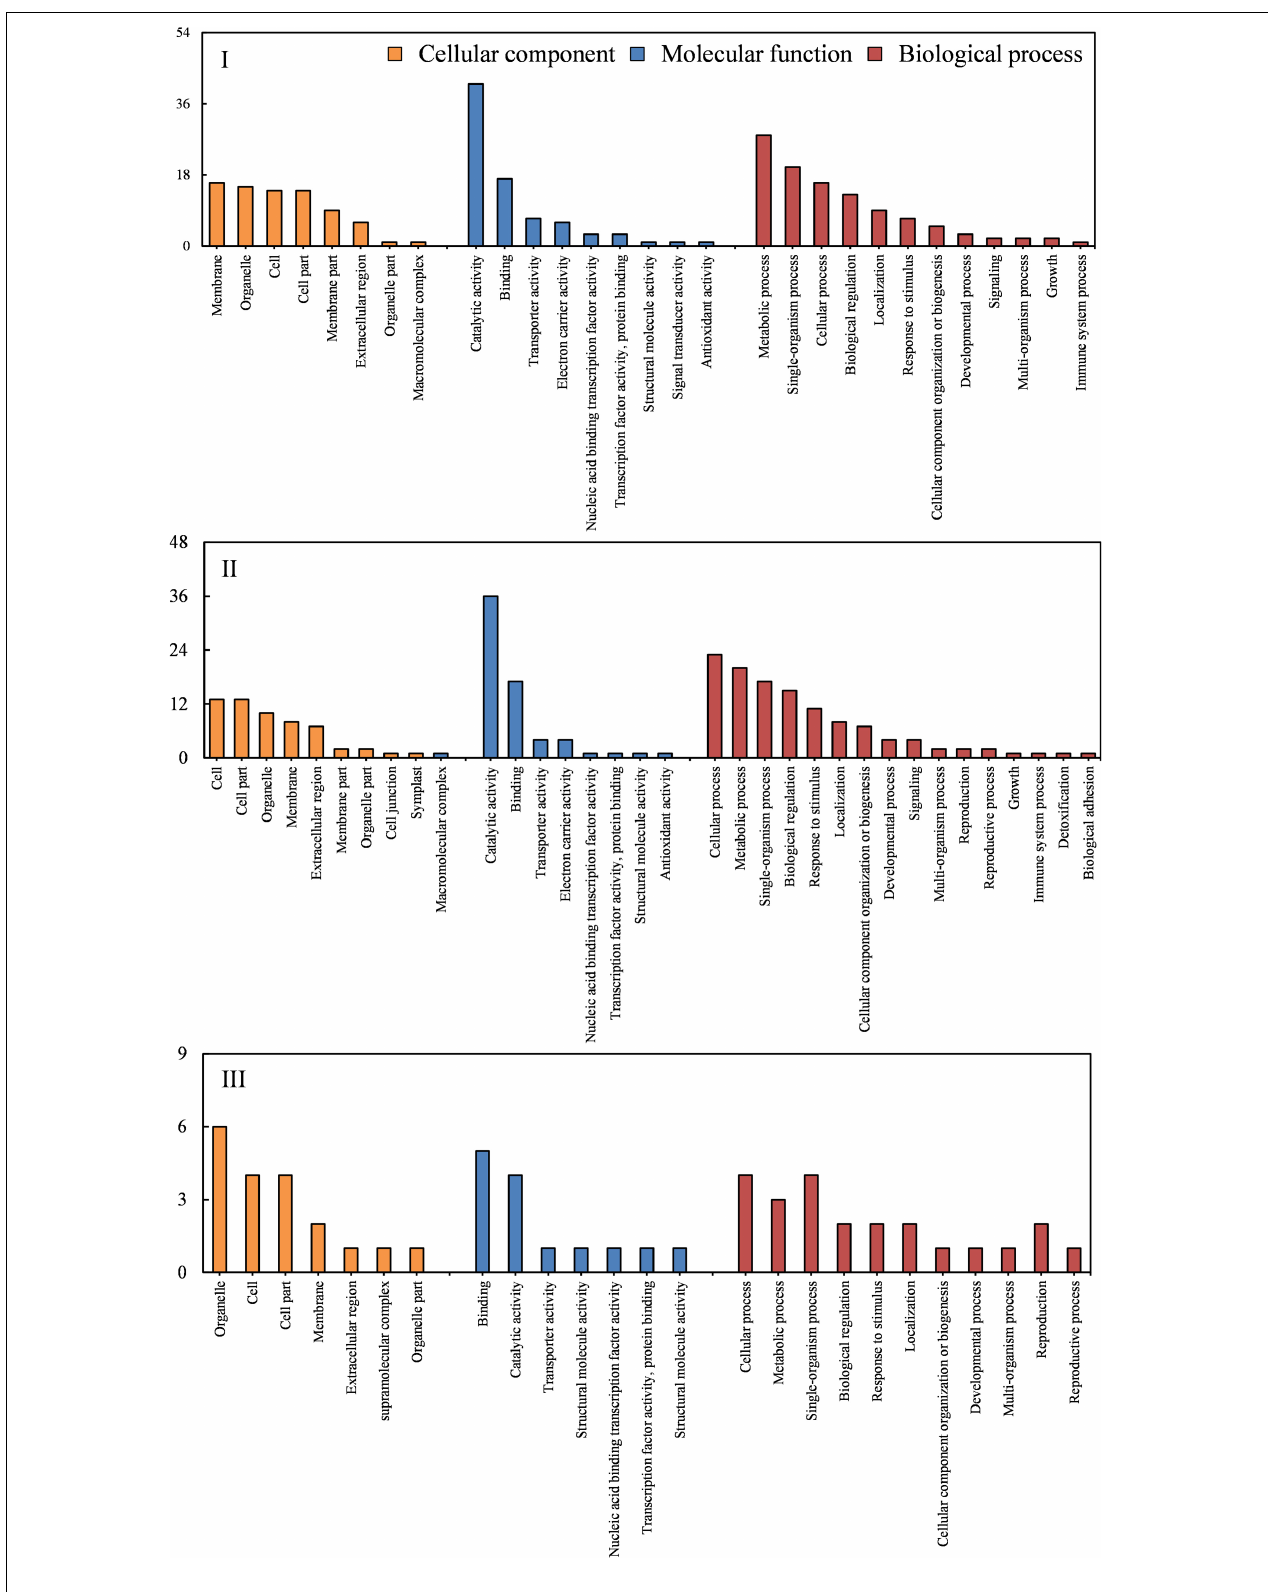
FIGURE 5 | Gene ontology (GO) analysis of DEGs at stage I (before bending), II (bending), and III (after bending).